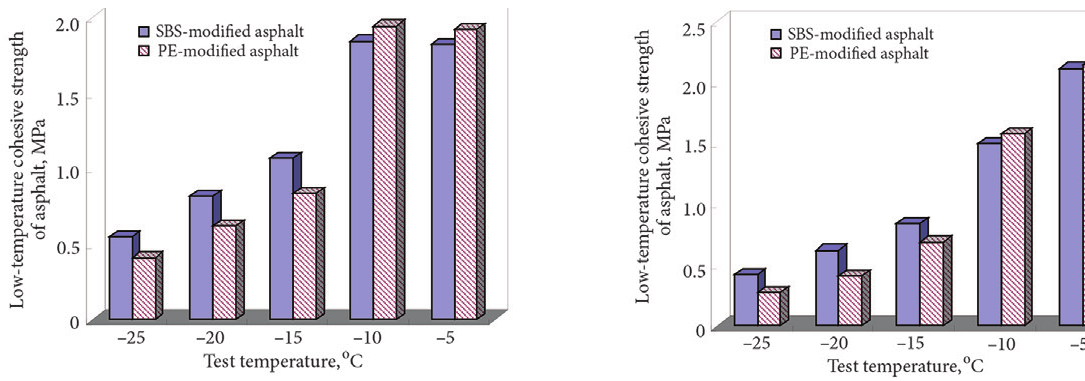
Figure 7. Change law of the two types of bitumen low-temperature cohesive strength after ageing for 24 h